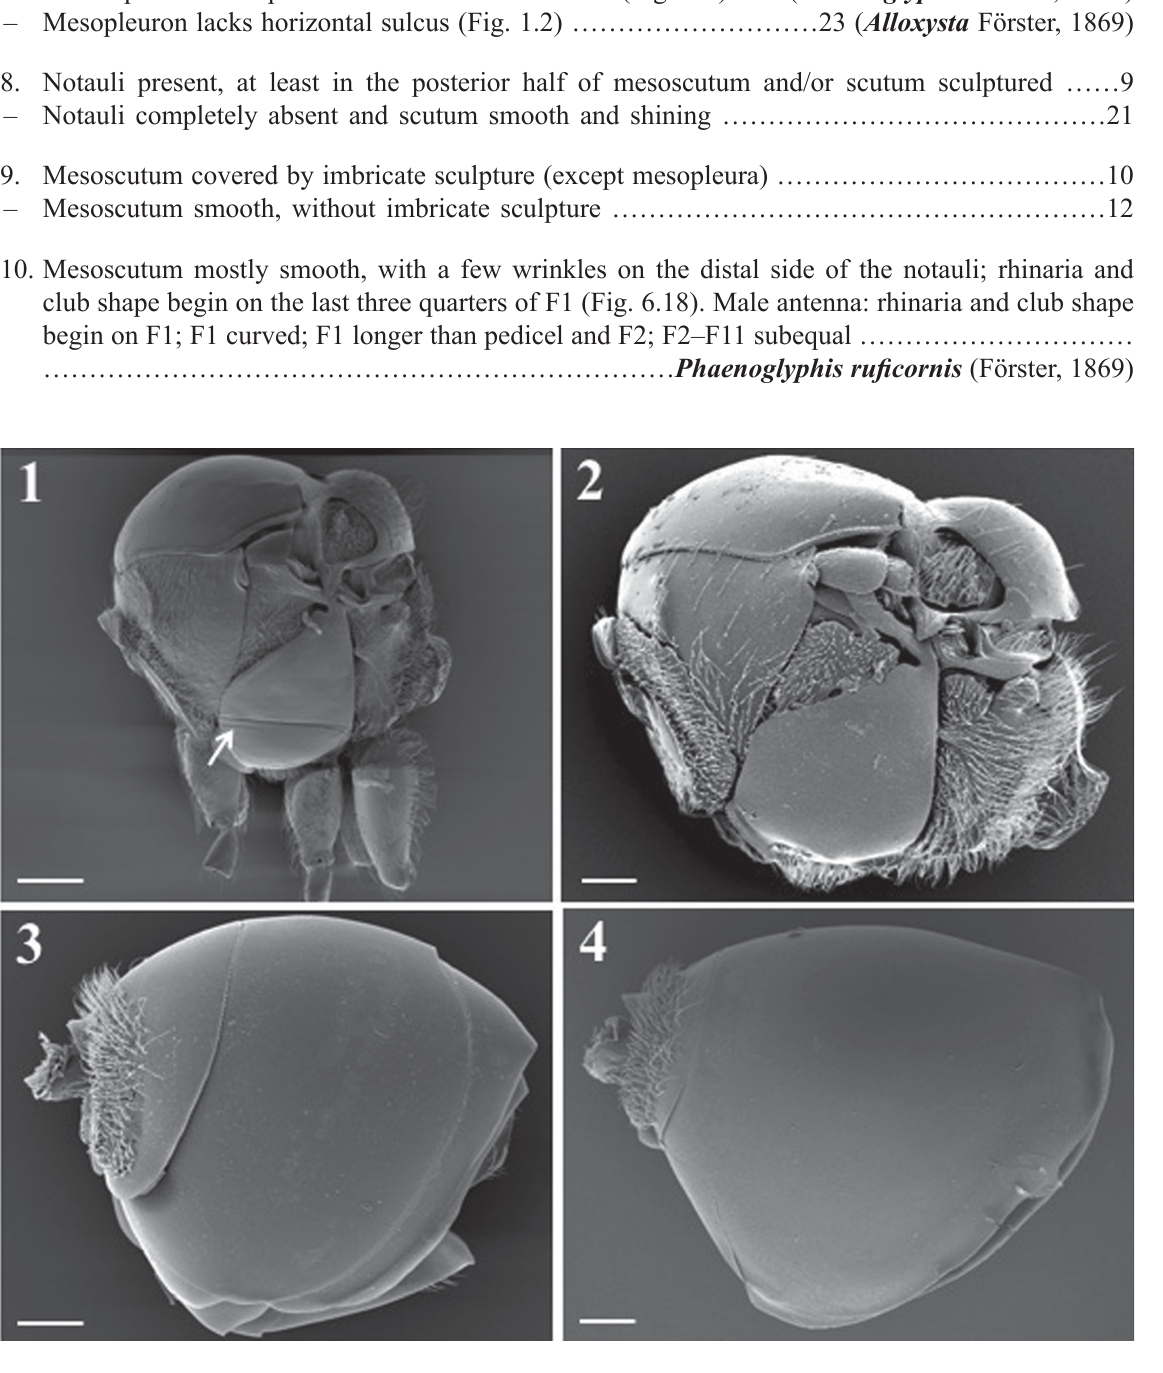
Fig. 1. Types of mesosoma and metasoma of the Charipinae Dalla Torre & Kieffer, 1910. 1. Mesosoma of Phaenoglyphis spp. 2. Mesosoma of Alloxysta spp. 3. Metasoma of Alloxysta spp. 4. Metasoma of Apocharips spp. Scale bars: 50